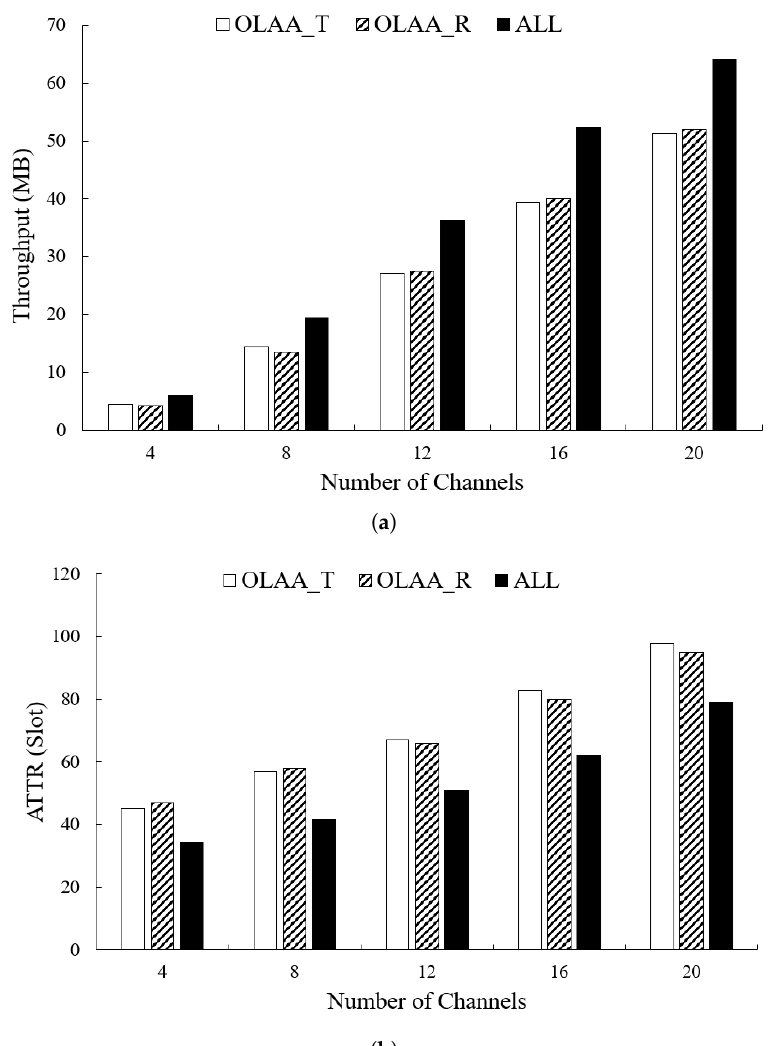
Figure 5. This figure displays the impact of the number of channels on the mesh topology’s perfor- mance in a synchronous network, as measured by two metrics: ( a ) throughput and ( b ) ATTR.